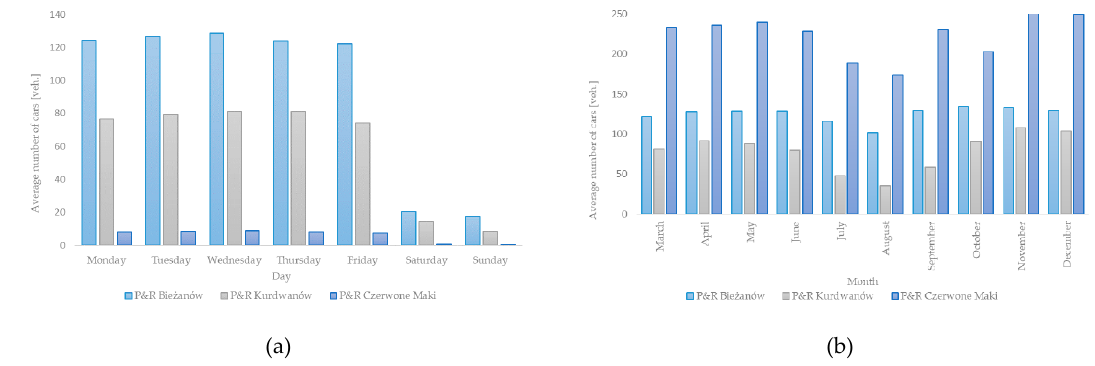
Figure 8. The average number of vehicles in the analyzed parking divided into: ( a ) days of the week; ( b ) months of the year.